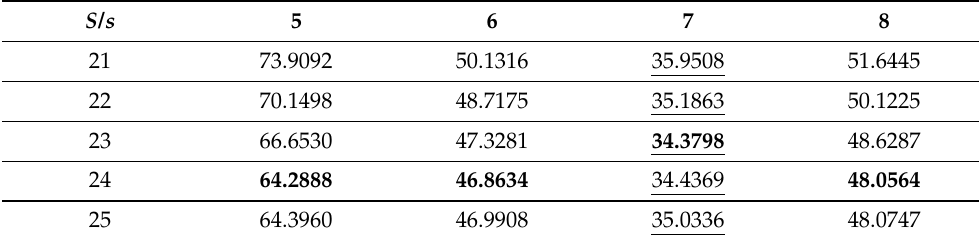
Table 1. The function of total cost rate with two variables S and s